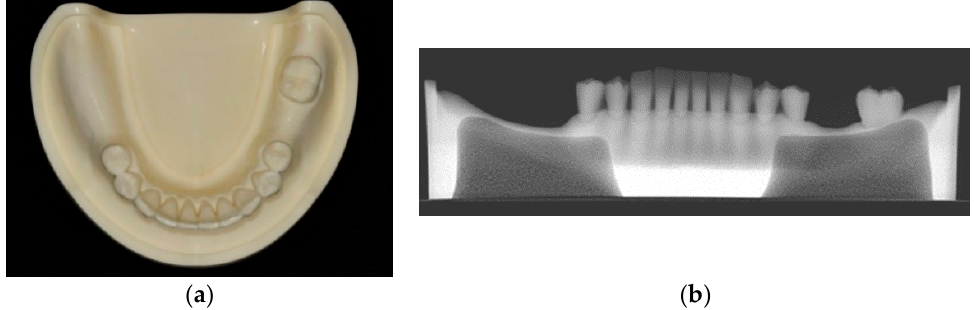
Figure 1. ( a ) The mandibular model used for the study. ( b ) The radiographic image of the model showed that the edentulous part had a two-layered construction to duplicate the bone anatomy.